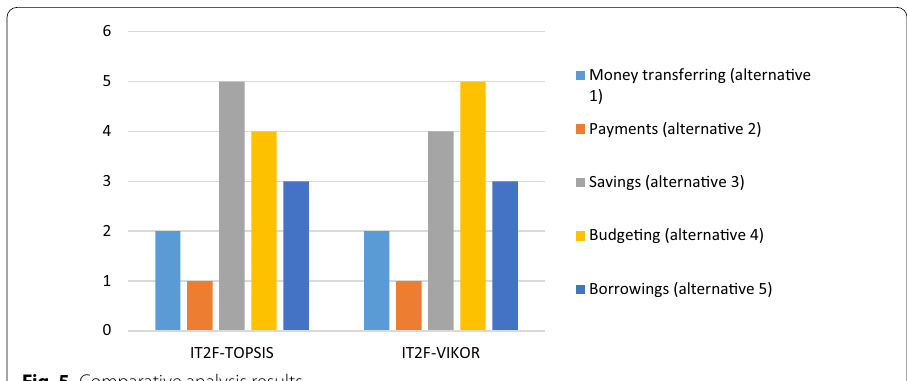
Fig. 5 Comparative analysis